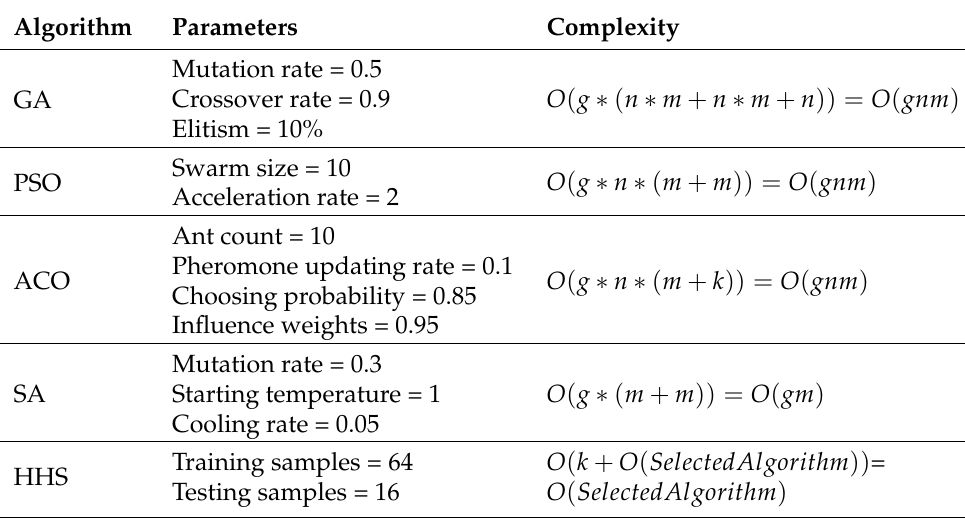
Table 2. Algorithm parameters and complexity